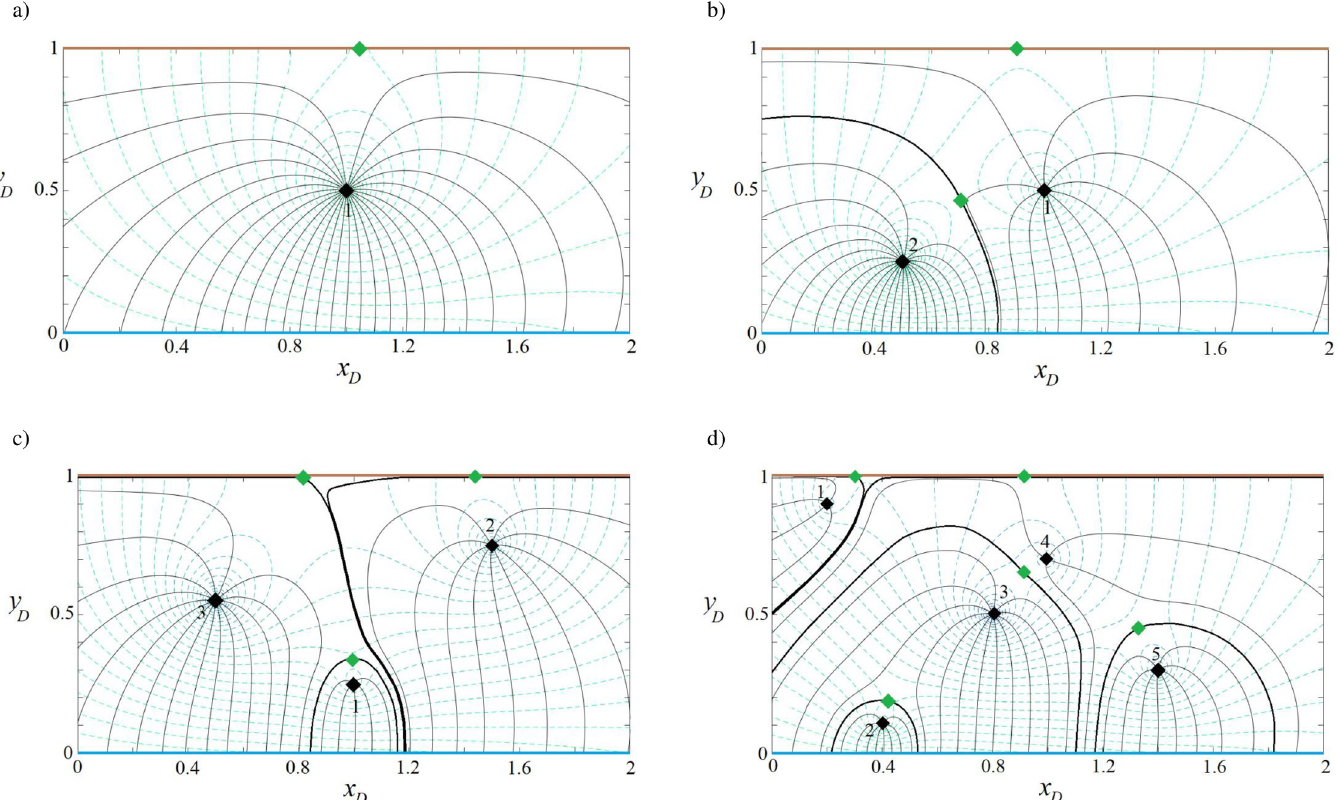
Fig 6. Velocity potential and stream function for one (a), two (b), three (c) and five (d) wells in a strip-shaped aquifer with barrier-inflow boundary conditions.